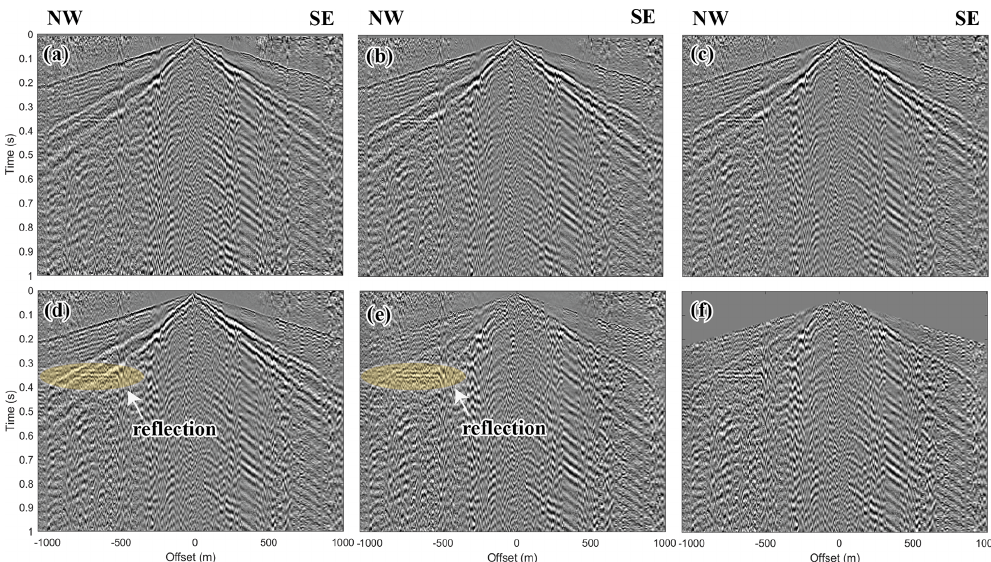
Figure 3. (a) Example raw shot gather after AGC application (Step 1), (b) after bandpass filtering (Step 2), (c) after refraction static correc- tions (Step 3), (d) after data regularization (Step 4), (e) after surface-wave suppression (Step 5), and (f) after top muting (Step 6). The yellow ellipses mark a clear reflection, which we interpret to be from the iron oxide